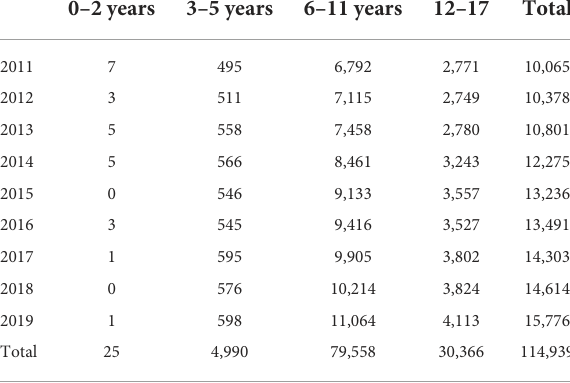
TABLE 3 Number of patients with an initial MPH prescription by age-group and